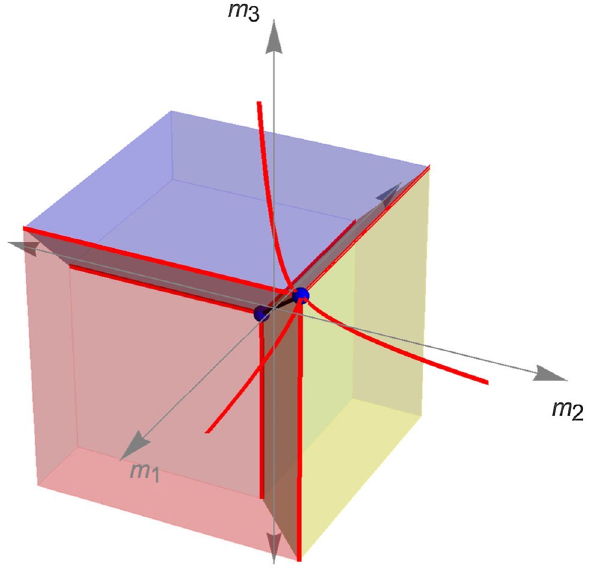
Fig. 7 The three-dimensional phase diagram of SU ( N ) k + p ψ 1 + q ψ 2 + ( F − p − q )ψ 3 with F / 2 − q ≤ k < F / 2. σ is represented by the thick black line between the two critical points. σ c are represented by the red, yellow, and blue regions, respectively. The diagonal sigma-models are the dark brown planes separating the cuboid quantum